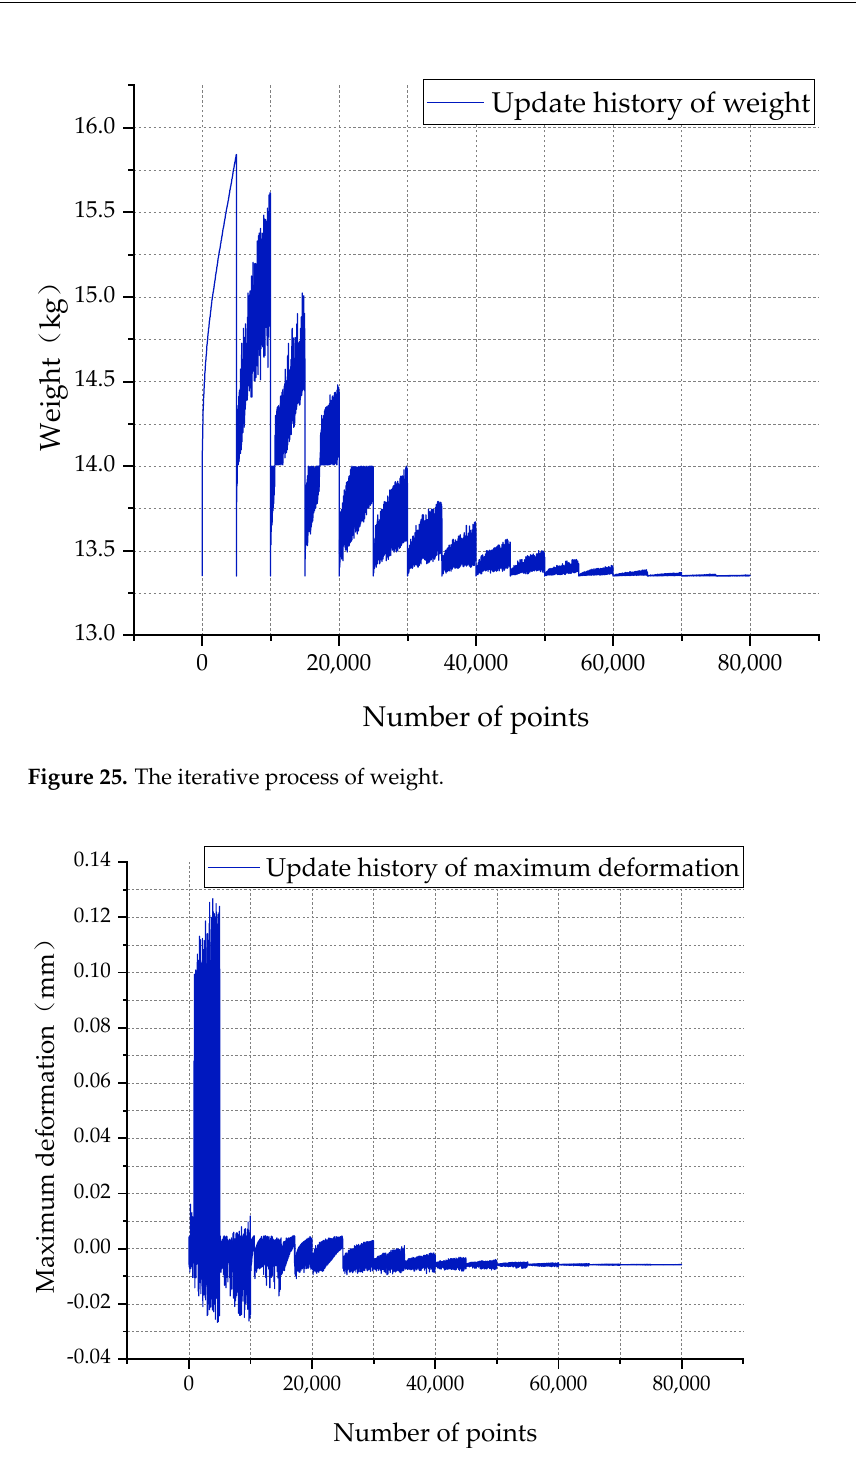
Figure 26. The iterative process of maximum deformation. The optimization results show three optimal candidate points (Figure 27). Candidate point 3 is selected as the final result of optimization, and the results compare with the parameters before optimization (Table 4). The maximum deformation of the lightweight drive rod after optimization is reduced to one-tenth of that in original model 1/10 and the weight is reduced by 1.9 kg compared with original